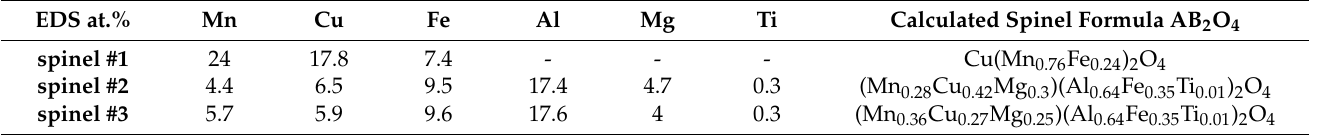
Figure 5. SEM/EDS Mapping of bauxite proppant BL 1630 ( a ) before and ( b ) after black spinel coating. Table 1. Chemical composition of spinel-type pigment in as-received condition, after coating process and thermal aging.